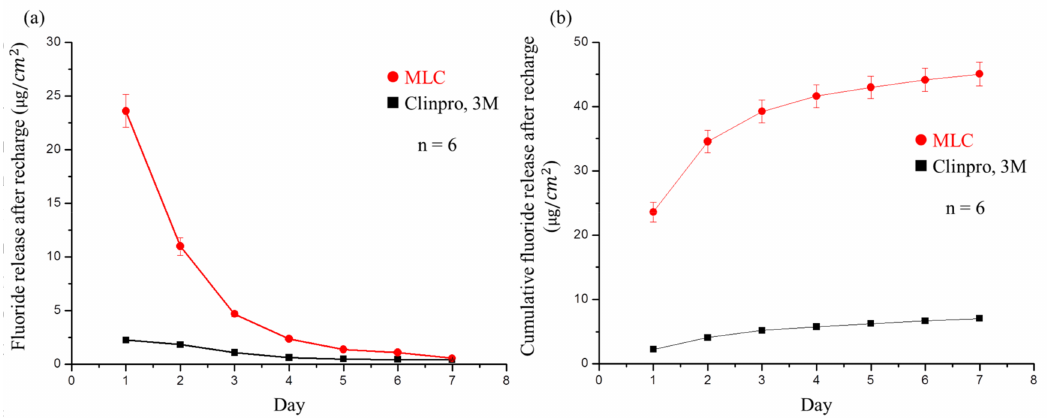
Figure 7. ( a ) Fluoride release after recharge per square centimeter of Clinpro TM and MLC each day for seven days. Significant di ff erences were observed between both materials at all times except on the seventh day. ( b ) Cumulative fluoride release from Clinpro TM and MLC after recharge every day for seven days. Significant di ff erences existed between both materials at all